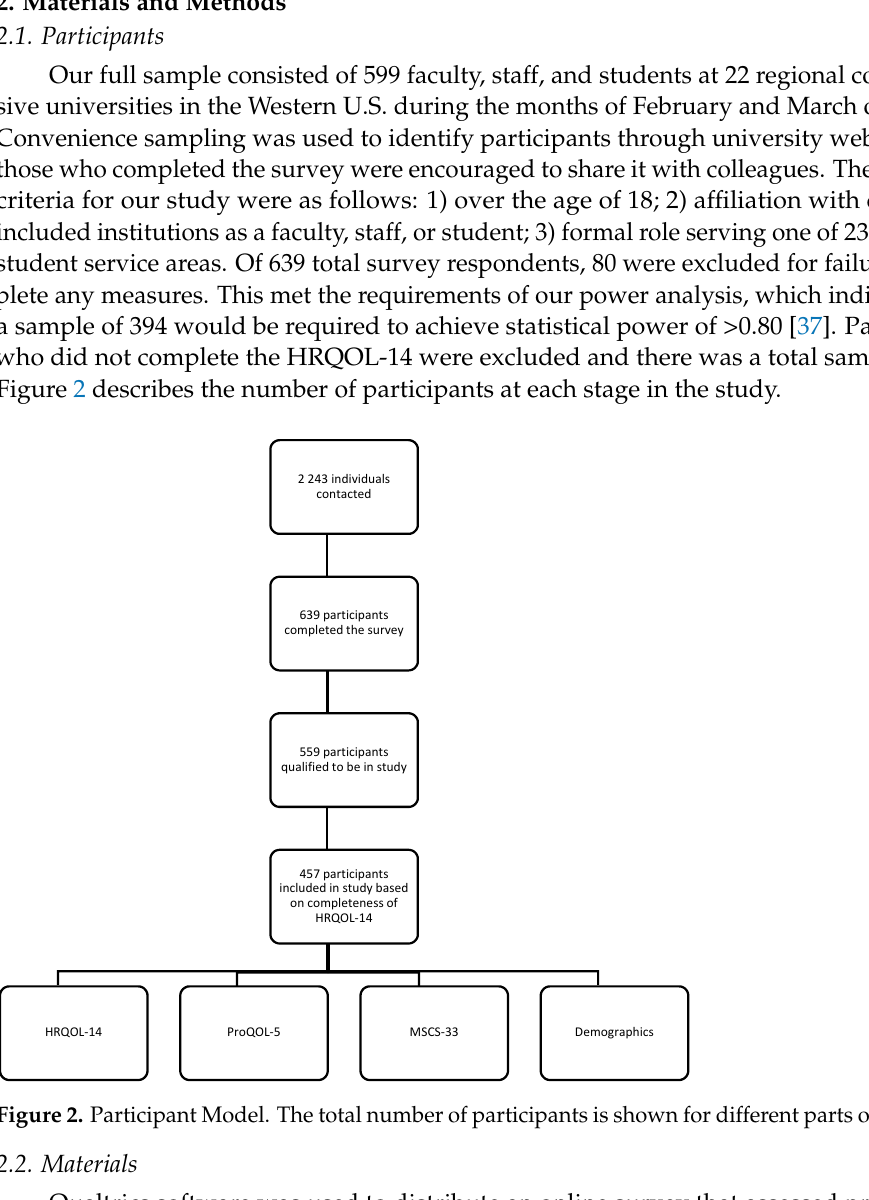
Figure 1. Conceptual Model. This figure is the conceptual model used to develop the hypotheses.